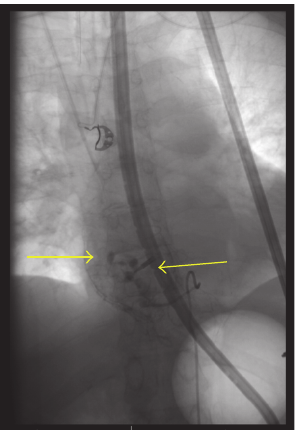
Figure 2: Angiography showing saccular dilations (pseudoa- neurysms) and a clip (arrows).